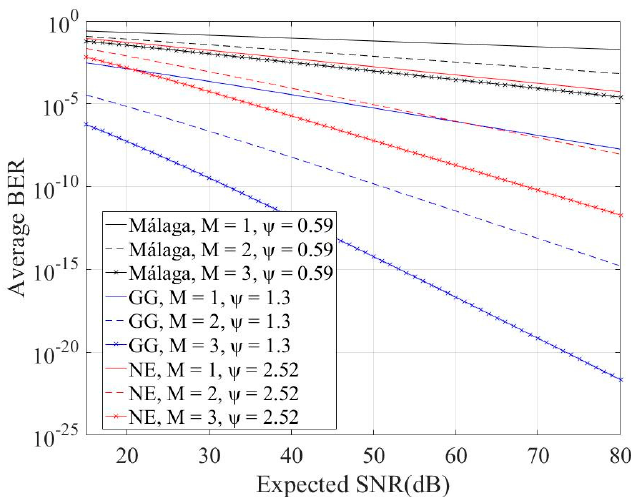
Figure 3. ABER for OOK scheme versus the expected SNR.